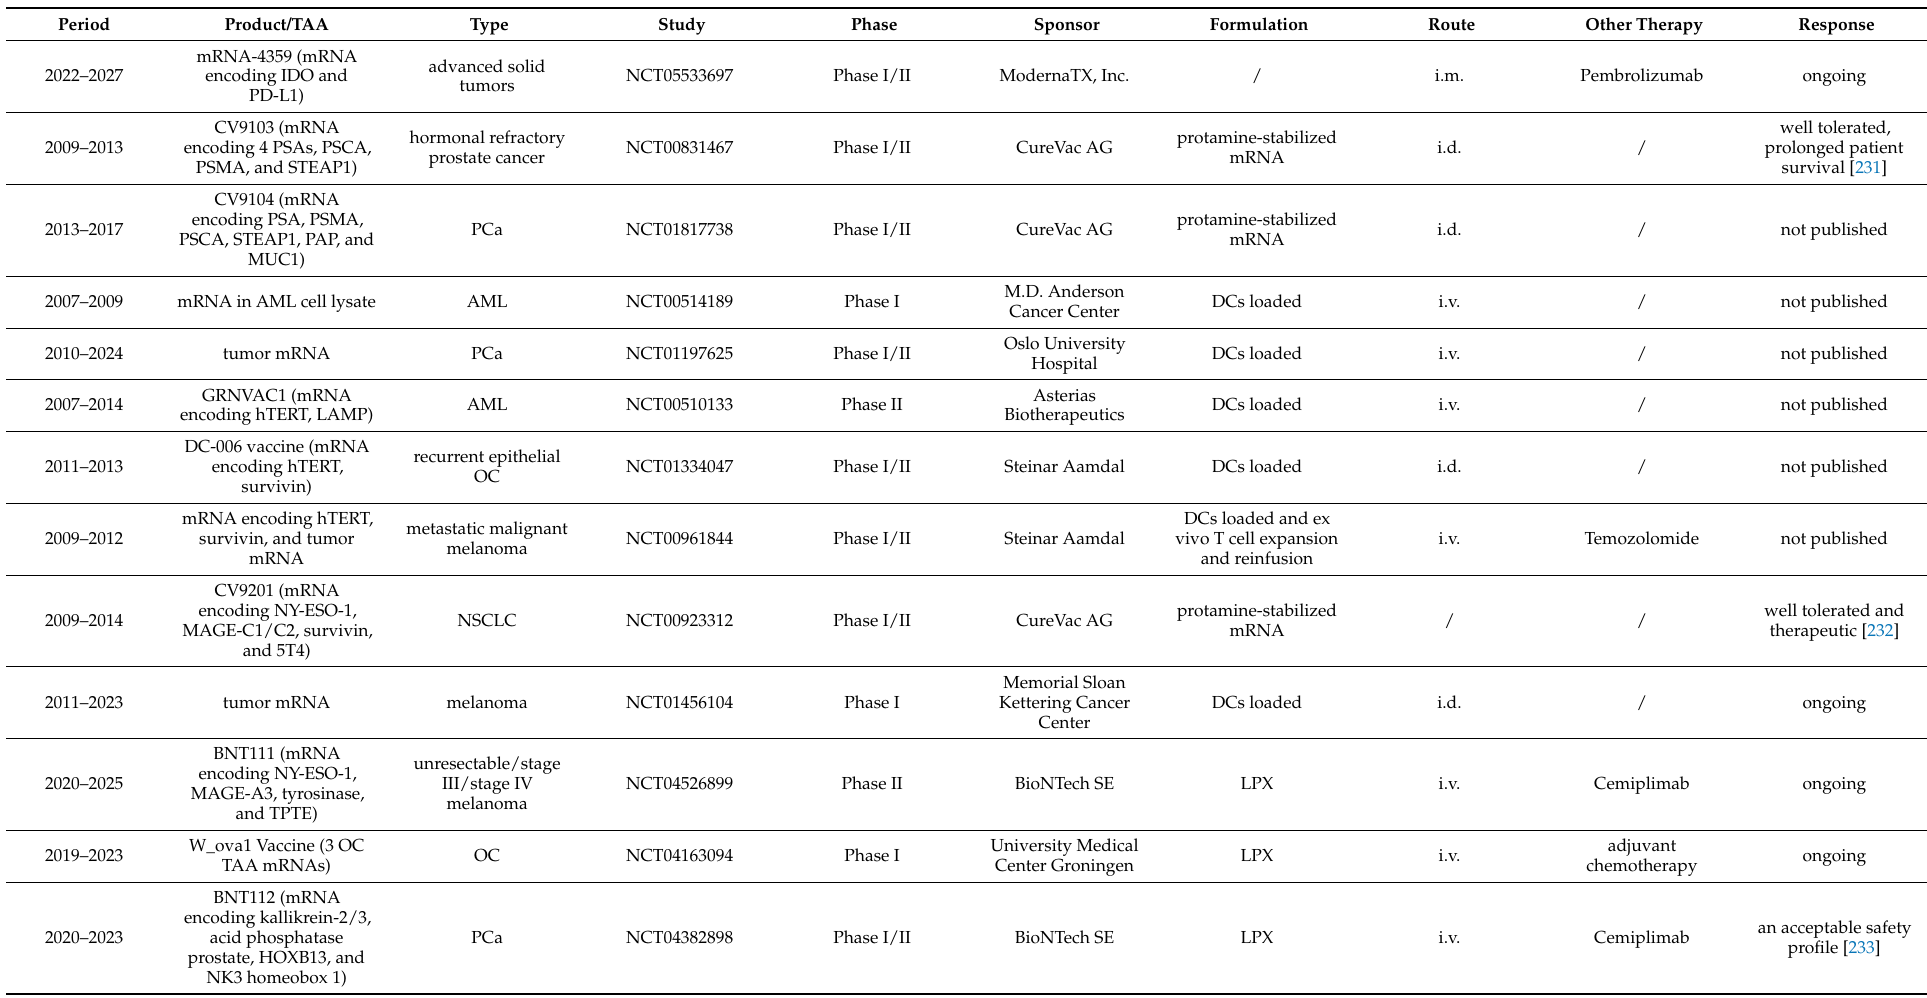
Table 2. Clinical trials of TAA